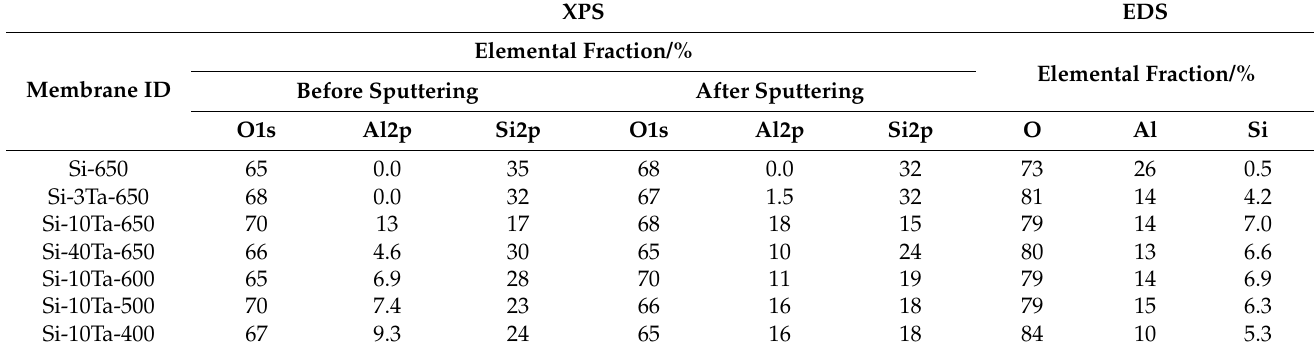
Table 3. Atomic concentrations from XPS analysis before and after a 30 s Ar sputter, and EDS of the